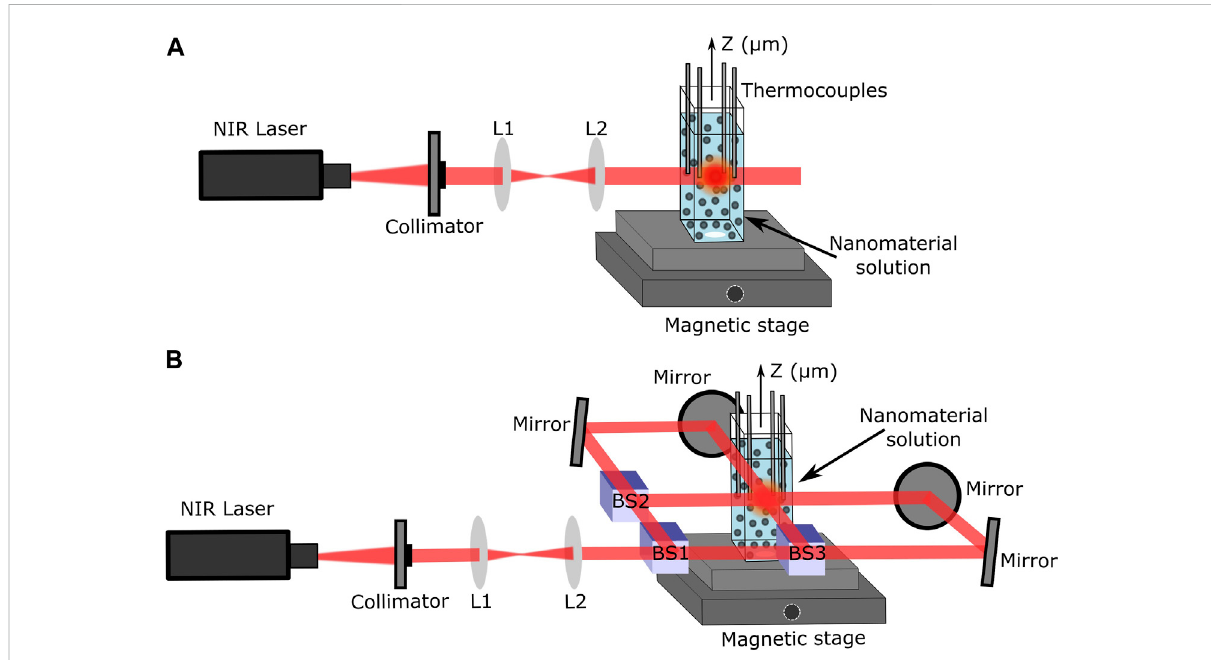
FIGURE 2 Laser setups using CrystaLaser 808 nm laser. (A) Four thermocouple setup for thermal measurements with only 1LB. (B) Beam splitting laser setup to uniformly heat solutions from four directions